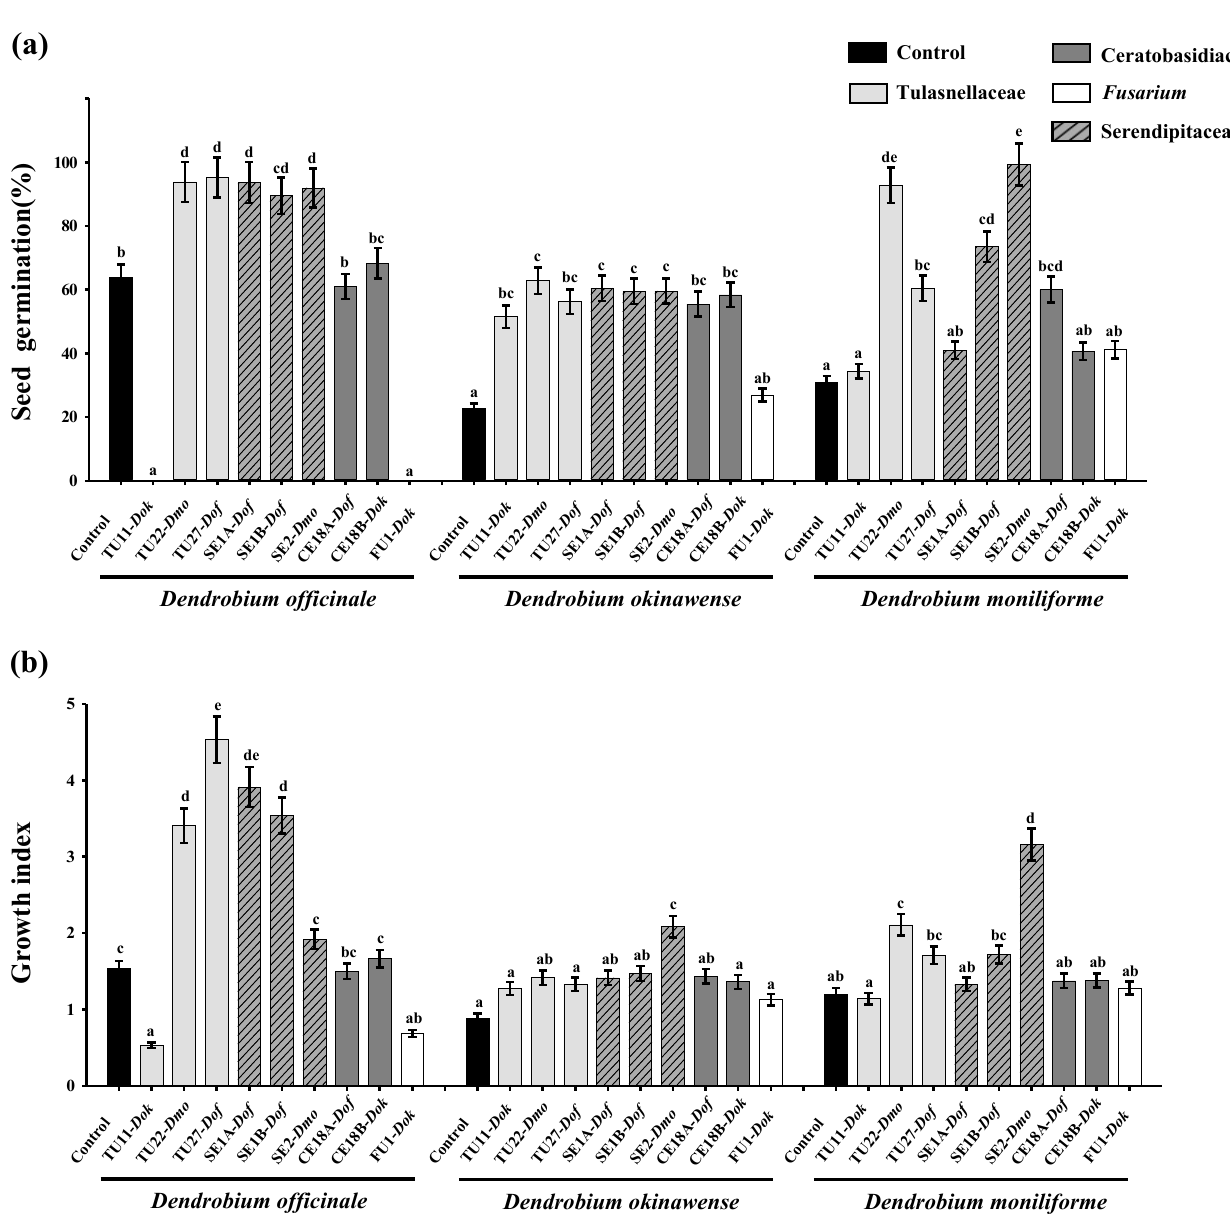
Figure 2. ( a ) Seed germination (%) and ( b ) seedling growth index (GI) of fungal isolates on Dendrobium officinale ( Dof ), D. okinawense ( Dok ) and D. moniliforme ( Dmo ) at 3 months after symbiotic culture. The host orchid is indicated after the fungal isolate name. Data are means of five replicates; bars indicate standard errors. Different letters denote significant differences according to the Tukey-Kramer test at the p < 0.05 level.